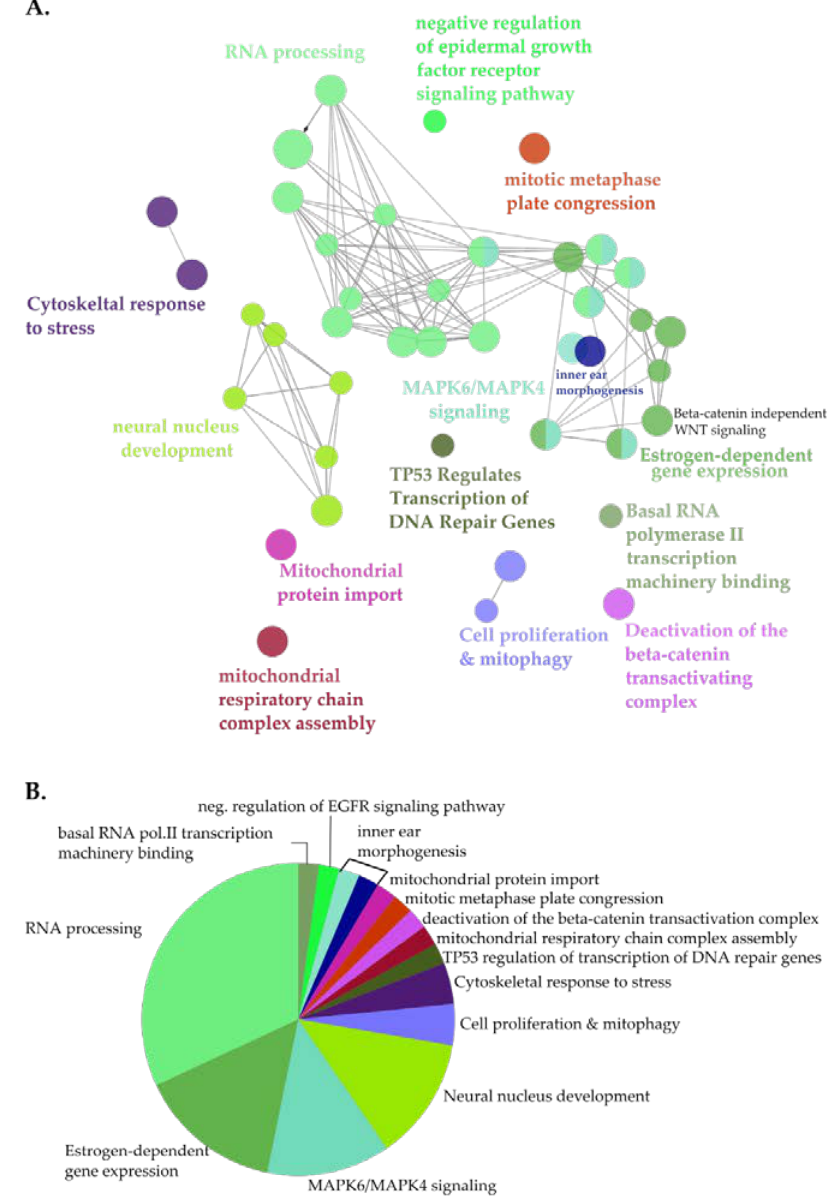
Figure 3. Clustered pathway analysis of NHA9-BioID proximal interactors. ( A ) Functionally grouped network of NHA9-BioID proximal interactors. Nodes correspond to functional clusters, resulting from term grouping based on their overlapping level. ( B ) Overview pie-chart showing functional groups. Statistical analysis was performed using the Cytoscape plugin ClueGo (v.2.5.5) using the hypergeometric test and the following parameters: p < 0.01, kappa-score (k) = 0.4; (min / %) genes = 3 / 4%, GO tree levels: 3-11. Ontology databases: GOBP, GOCC, and GOMF, Reactome Pathways and KEGG.